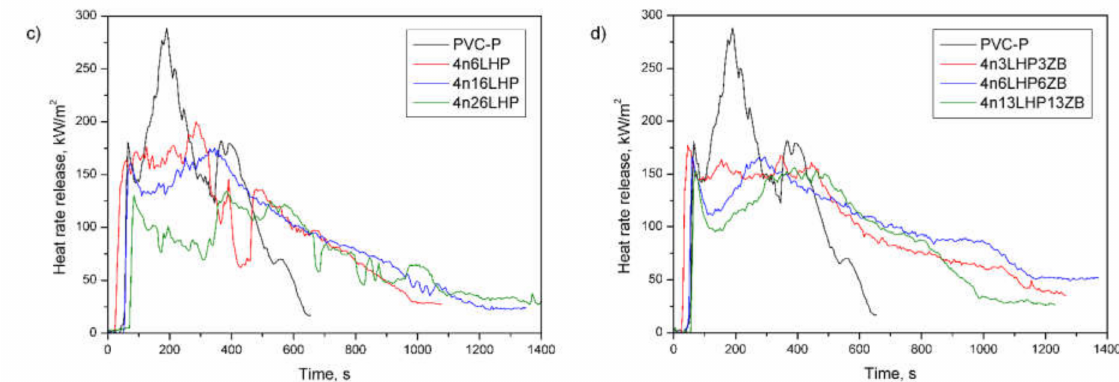
Figure 7. Representative curves of heat release rates of the PVC-P and PVC-P with APP ( a ) or n/H ( b ), n/LHP ( c ), or n/LHP/ZB ( d ) systems.